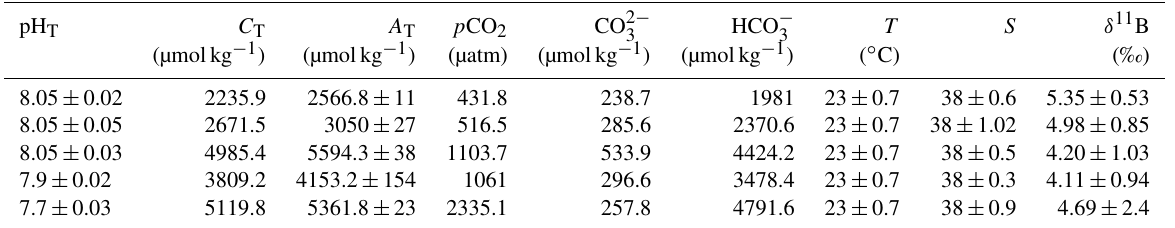
Table 1. Average properties of the manipulated seawater culture medium from four samples (two from the start of the incubation and two from the end of the